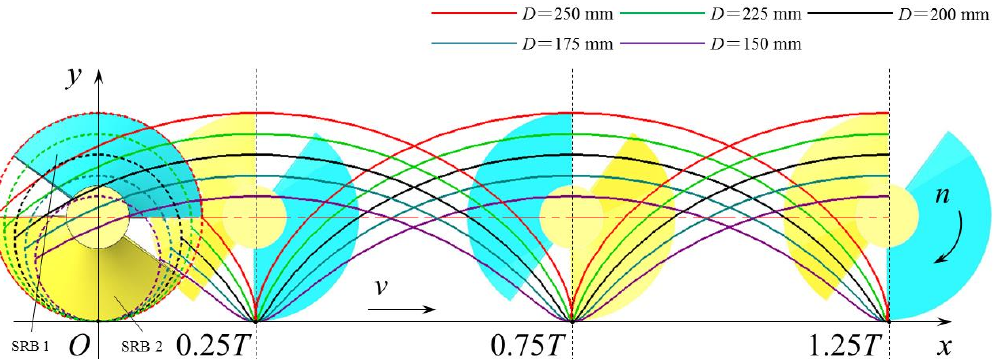
Figure 5. The motion trajectory of the tip of the SRB at different D values. Note: D is the ODRD, mm; n is the RVSS, rpm; v is the operating velocity of machines, km/h. In order to describe the motion law of the SSM more clearly, the two sets of SRB in green are expressed as the blue SRB 1 and the yellow SRB 2.